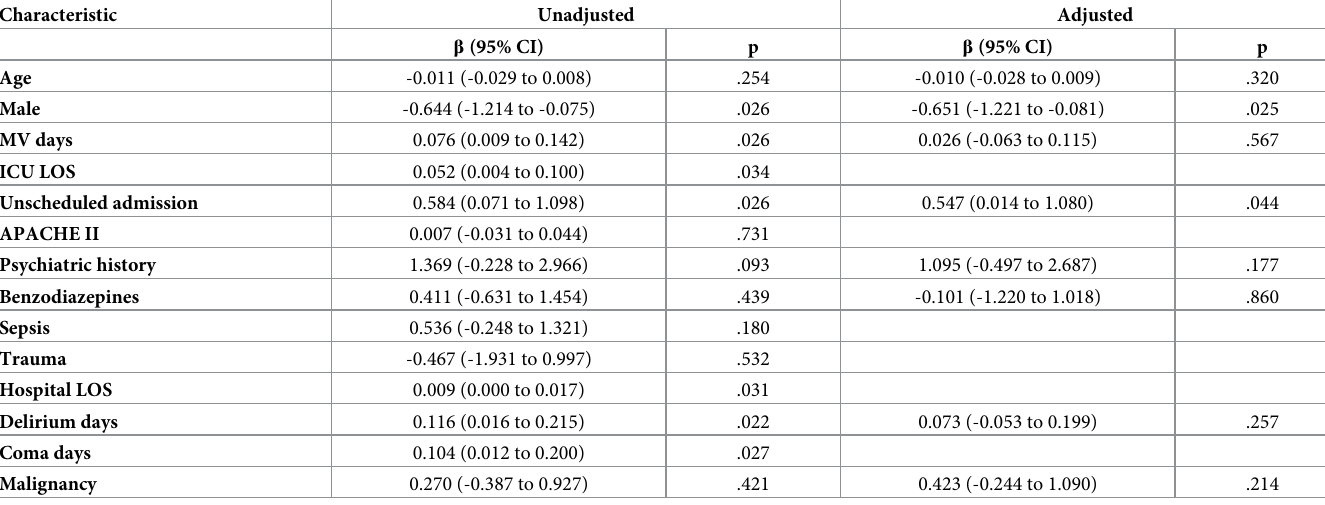
Table 3. Risk factors of the severity of anxiety symptoms in univariable and multivariable analyses using a multilevel linear regression model. Characteristic Unadjusted